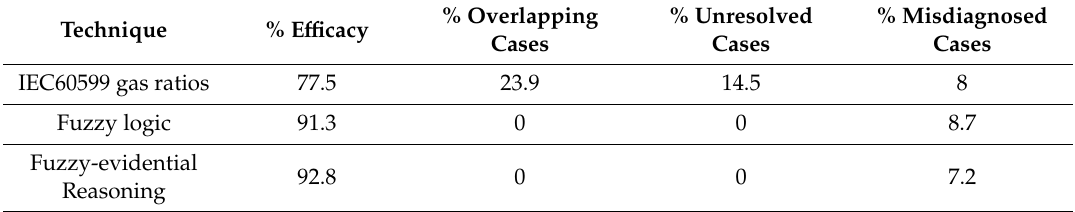
Table 10. Comparison summary in